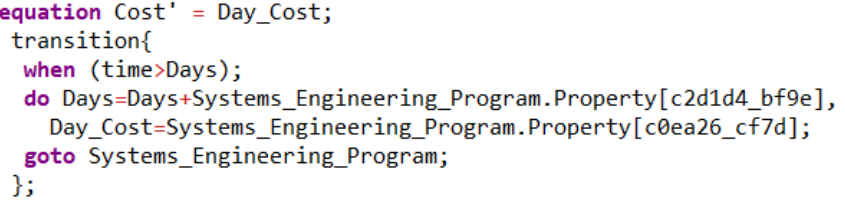
Figure 9. KARMA language for analyzing the dynamic cost.